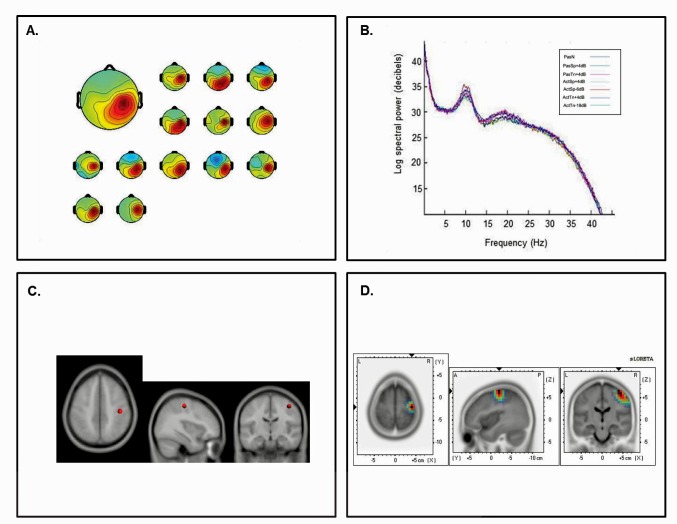
Cluster results for the right-hemisphere µ component.A) mean scalp potential distribution (W−1) scaled to RMS microvolts and individual scalp distributions for each participant; B) mean spectra of the component as a function of condition, C) average equivalent current dipole location, and D) maximum current source density voxels (t-values) with greater values in darker colors and smaller values in lighter colors (NIH Micro template) (at p<.001 corrected for multiple comparisons).